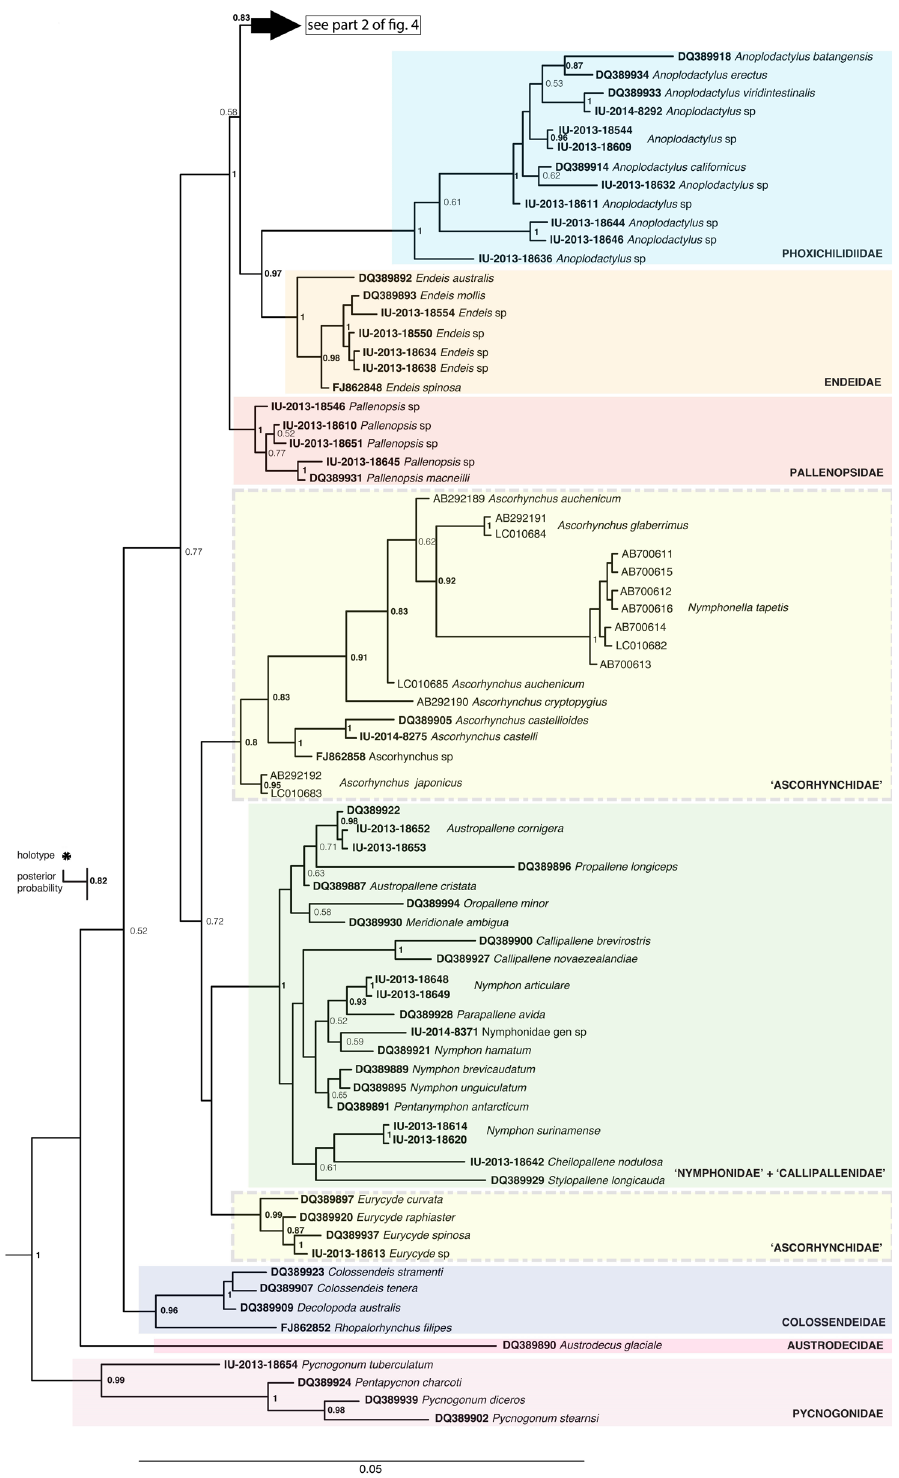
Fig. 4. Bayesian tree of Pycnogonida based on 159 sequences of the nuclear 18S rRNA gene. Coloured rectangles show non-ammotheid families and coloured branches discriminate ammotheid genera. The numbers at the nodes indicate posterior probabilities greater than 0.5. Asterisks after taxon names indicate holotype specimens. Outgroups were removed for better readability. The arrow at the top of the tree shows the connection with Part 2 of the tree (see next